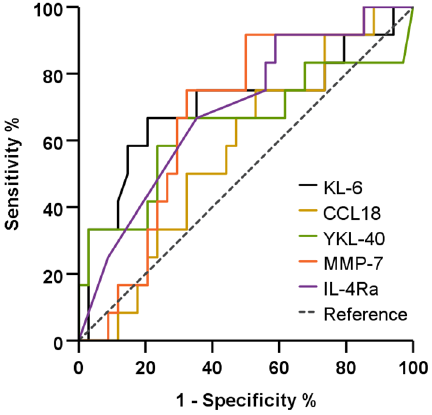
Figure 1. Comparison of the ROC curves of biomarkers for 10-year mortality in patients with SJS-ILD. KL-6 (AUC = 0.750, 95% CI 0.509–0.901; P = 0.037), CCL18 (AUC = 0.569, 95% CI 0.391–0.746, P = 0.484), YKL-40 (AUC = 0.642, 95% CI 0.431–0.854, P = 0.147), IL-4Ra (AUC = 0.692, 95% CI 0.539–0.820, P = 0.053), MMP-7 (AUC = 0.676, 95% CI 0.513–0.840, P = 0.072). AUC area under the curve, CCL18 CC chemokine ligand 18, CI confidence interval, ILD interstitial lung disease, IL-4Ra interleukin-4 receptor alpha, KL-6 Krebs von den Lungen-6, MMP-7 matrix metalloproteinase-7, SJS Sjögren syndrome, YKL-40 chitinase-3-like-1.